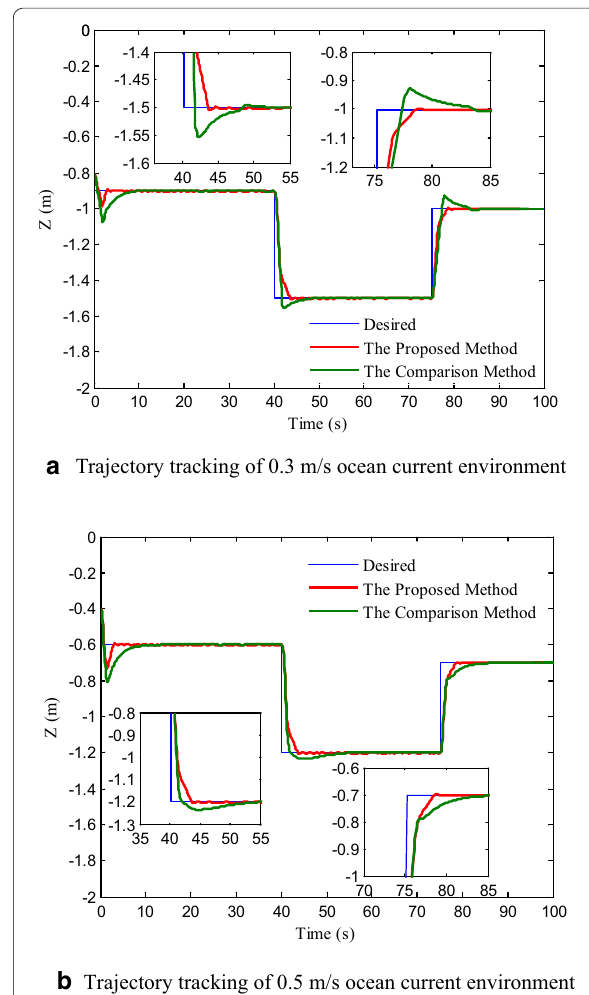
Figure 3 Simulation curves of mutation trajectory tracking in different ocean current environments